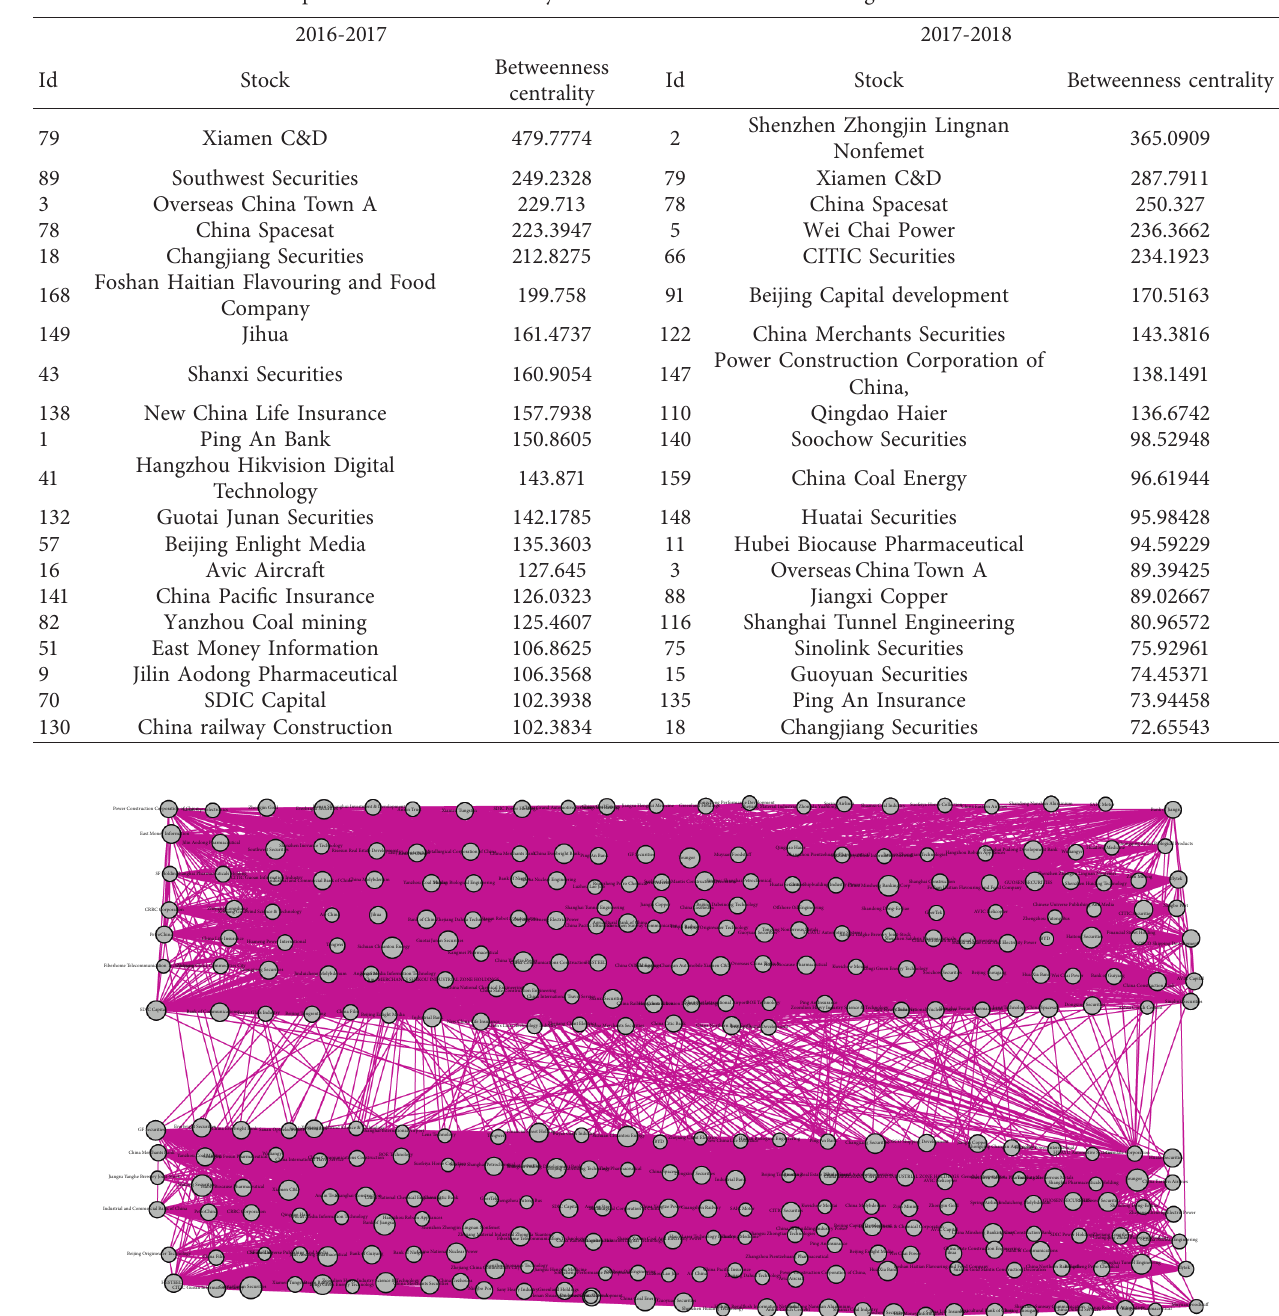
Table 7: Top 20 betweenness centrality stocks of CSI 300 network during 2016-2017 and 2017-2018.